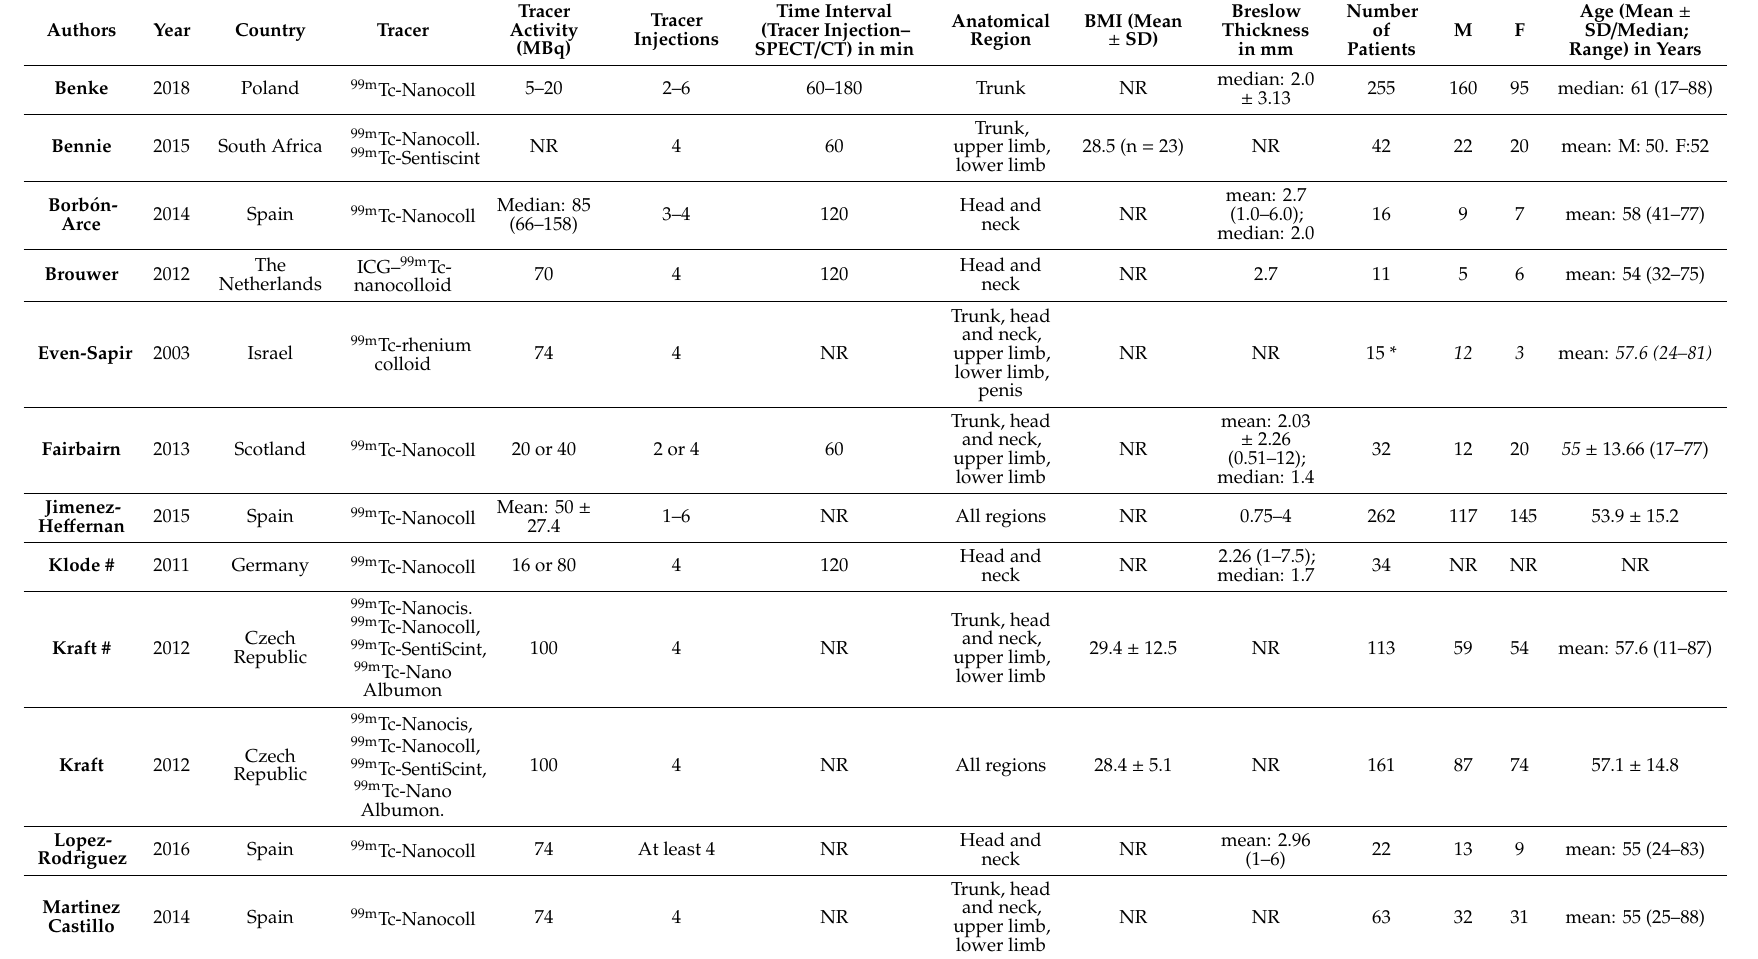
Table 1. Characteristics of the twenty studies selected for the